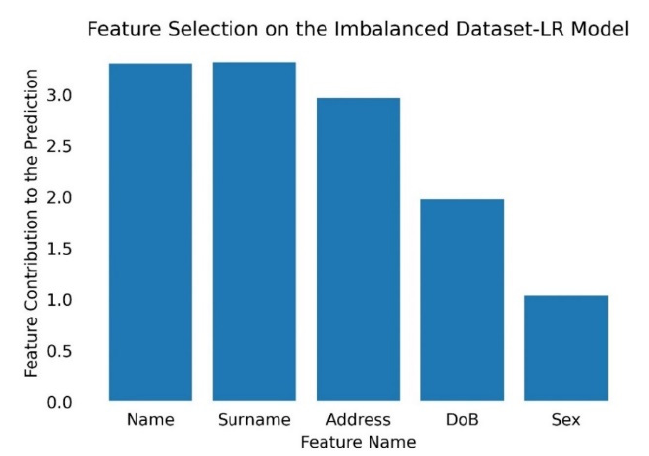
Figure 3. Feature importance of the LR model using the imbalanced dataset as